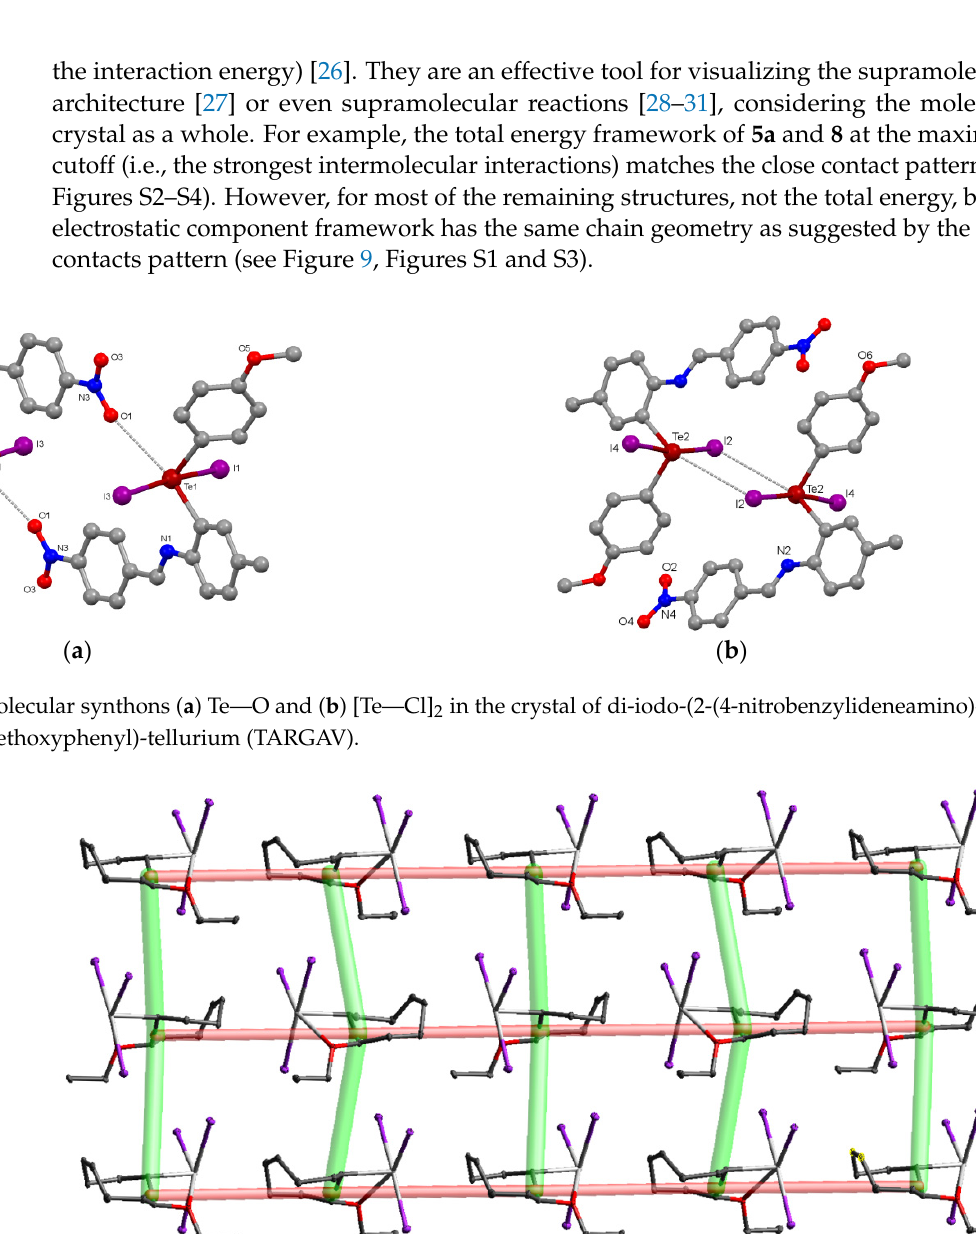
Figure 9. The energy framework of 2 . The electrostatic component is represented by a red cylinder (cutoff 30 kJ/mol), dispersion—by a green cylinder (Cutoff 35 kJ/mol). Notice the electrostatically stabilized chains, linked with one another by dispersion (van der Waals) interactions.